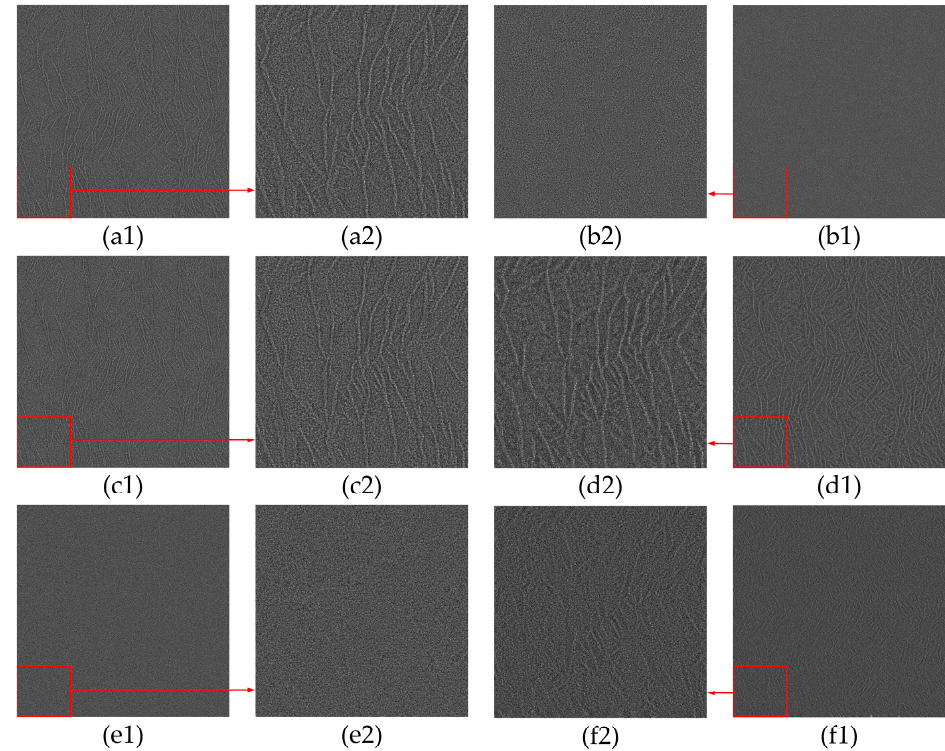
Figure 13. Ratio images by noisy ALOS-2 SAR image and the ( a1 ) SRAD, ( b1 ) DPAD, ( c1 ) EnLee, ( d1 ) PPB, ( e1 ) SAR-BM3-D, and ( f1 ) FANS filtered images. ( a2 – f2 ) are the enlarged images of the red rectangle from ( a1 – f1 ).